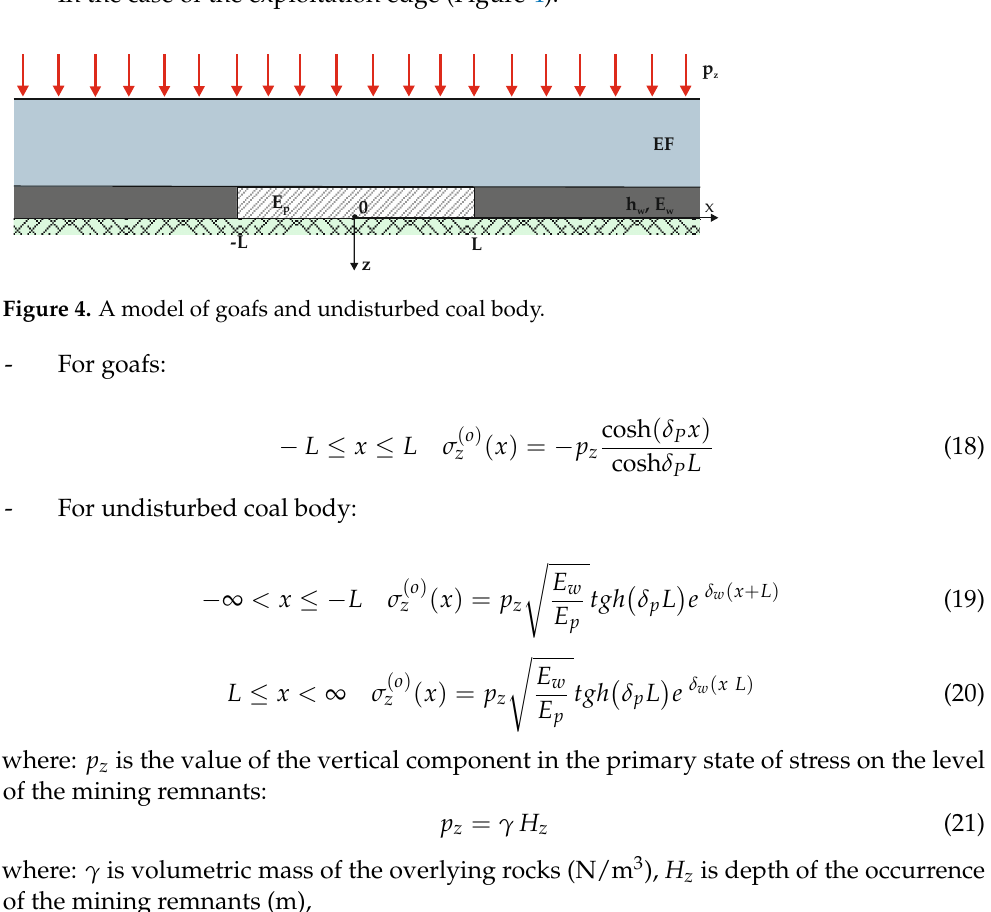
( b ) Figure 3. Modelled impacts of: ( a ) exploitation edge and ( b ) residual pillar on the multi-layer me- dium including the tremor-inducing layer. Since the influence of the mining remnants on the surrounding rock mass is the result of non-uniform stress distribution, the concept of an additional stress,